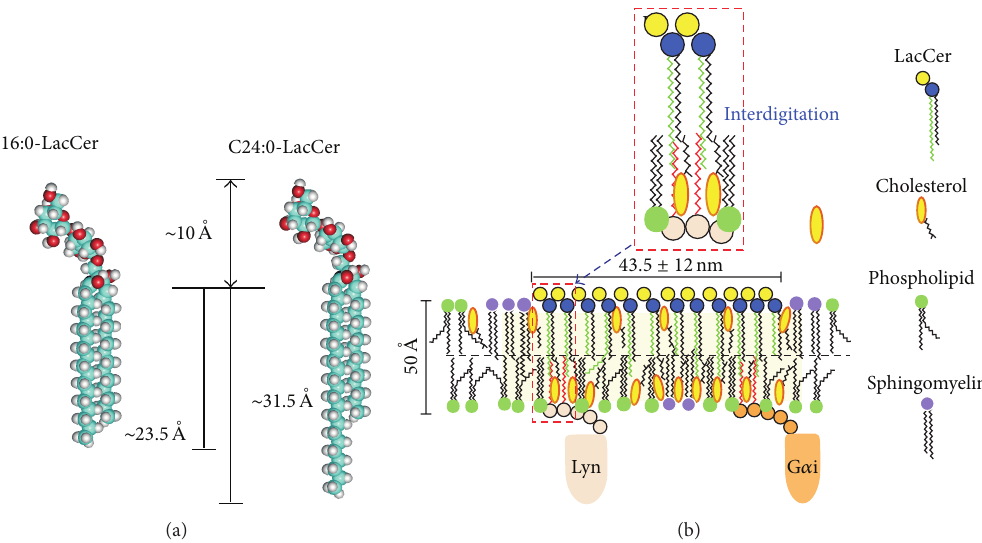
Figure 2: LacCer-enriched microdomains. (a) Size of LacCer microdomains containing C16:0 and C24:0 fatty acid chain. (b) LacCer forms lipid microdomains on plasma membrane of human neutrophils and acts as a signal transduction platform. The C24 fatty acid chains of LacCer interdigitate into inner leaflet of plasma membranes and directly interact with Lyn and G 𝛼 i. These molecules associate with LacCer to mediate signaling from outside to inside, resulting in neutrophil chemotaxis, migration, and